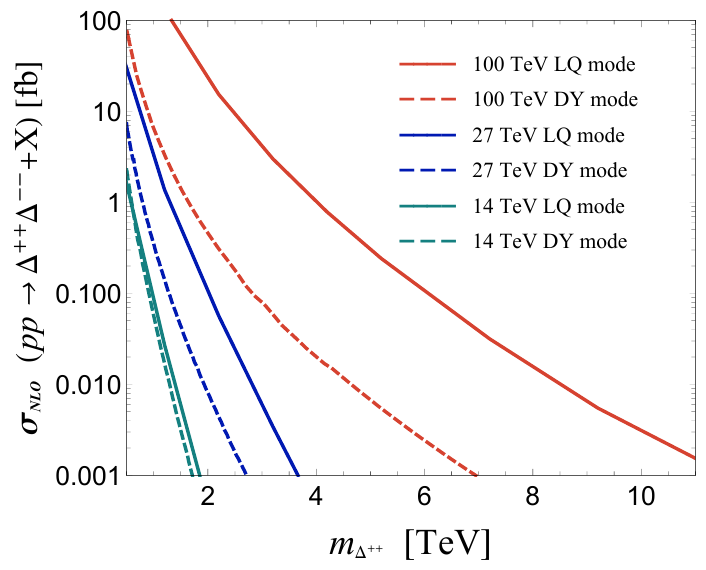
Figure 12 . Comparison of the NLO pair-production cross-sections for the doubly-charged scalars in the DY channel ( pp → ∆ ++ ∆ −− ) versus the LQ channel ( pp → ∆ ++ ∆ −− + ω 2 / 3 ω − 2 / 3 ) as a √ function of the doubly-charged scalar mass at s = 14, 27 and 100